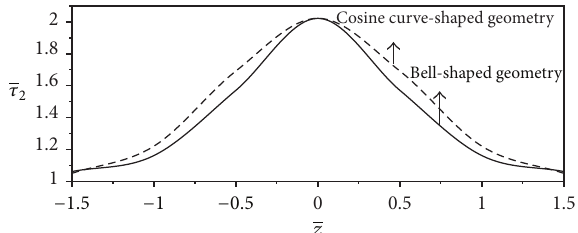
Figure 13: Variations of skin friction 𝜏 2 with axial distance for different fluid models with cosine-shaped stenosis.